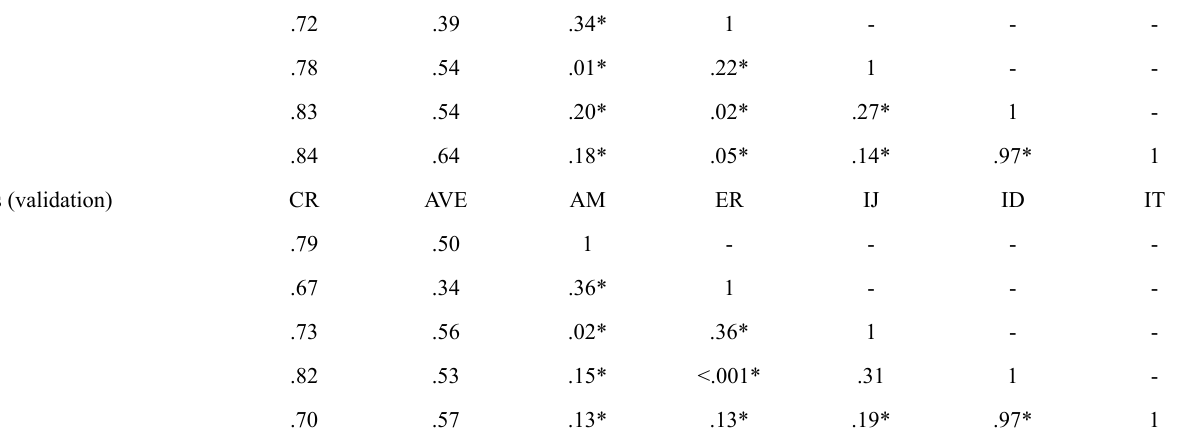
Table 4 Fit indices for the invariance of the measurement model of the PLOCQ in the Portuguese sample across samples and gender